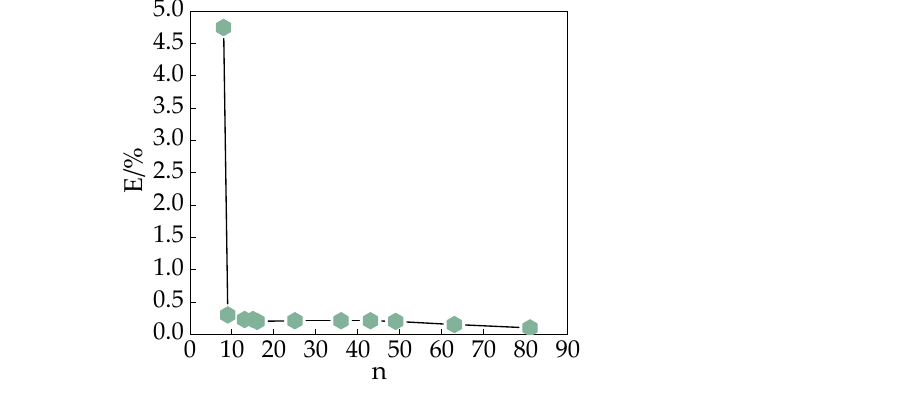
Figure 10. The influence of the number of corner points on the performance of the calibration plate.